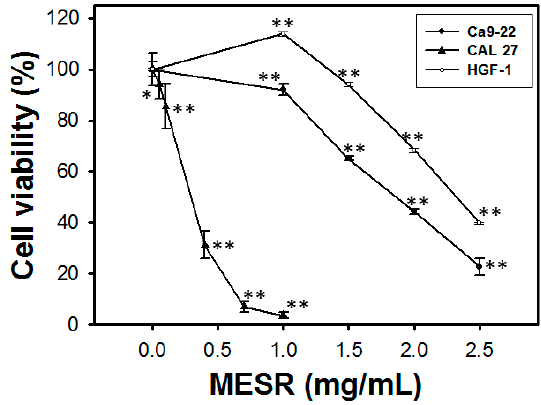
Figure 1. MTS-based cell viability of oral cancer Ca9-22 and CAL 27 cells as well as oral normal HGF-1 cells was differentially decreased by MESR. Cells were incubated with MESR (0–2.5 mg/mL) for 24 h. Data, means ± SDs ( n = 11, 10, and 3, respectively). * p < 0.001 and ** p < 0.001 against